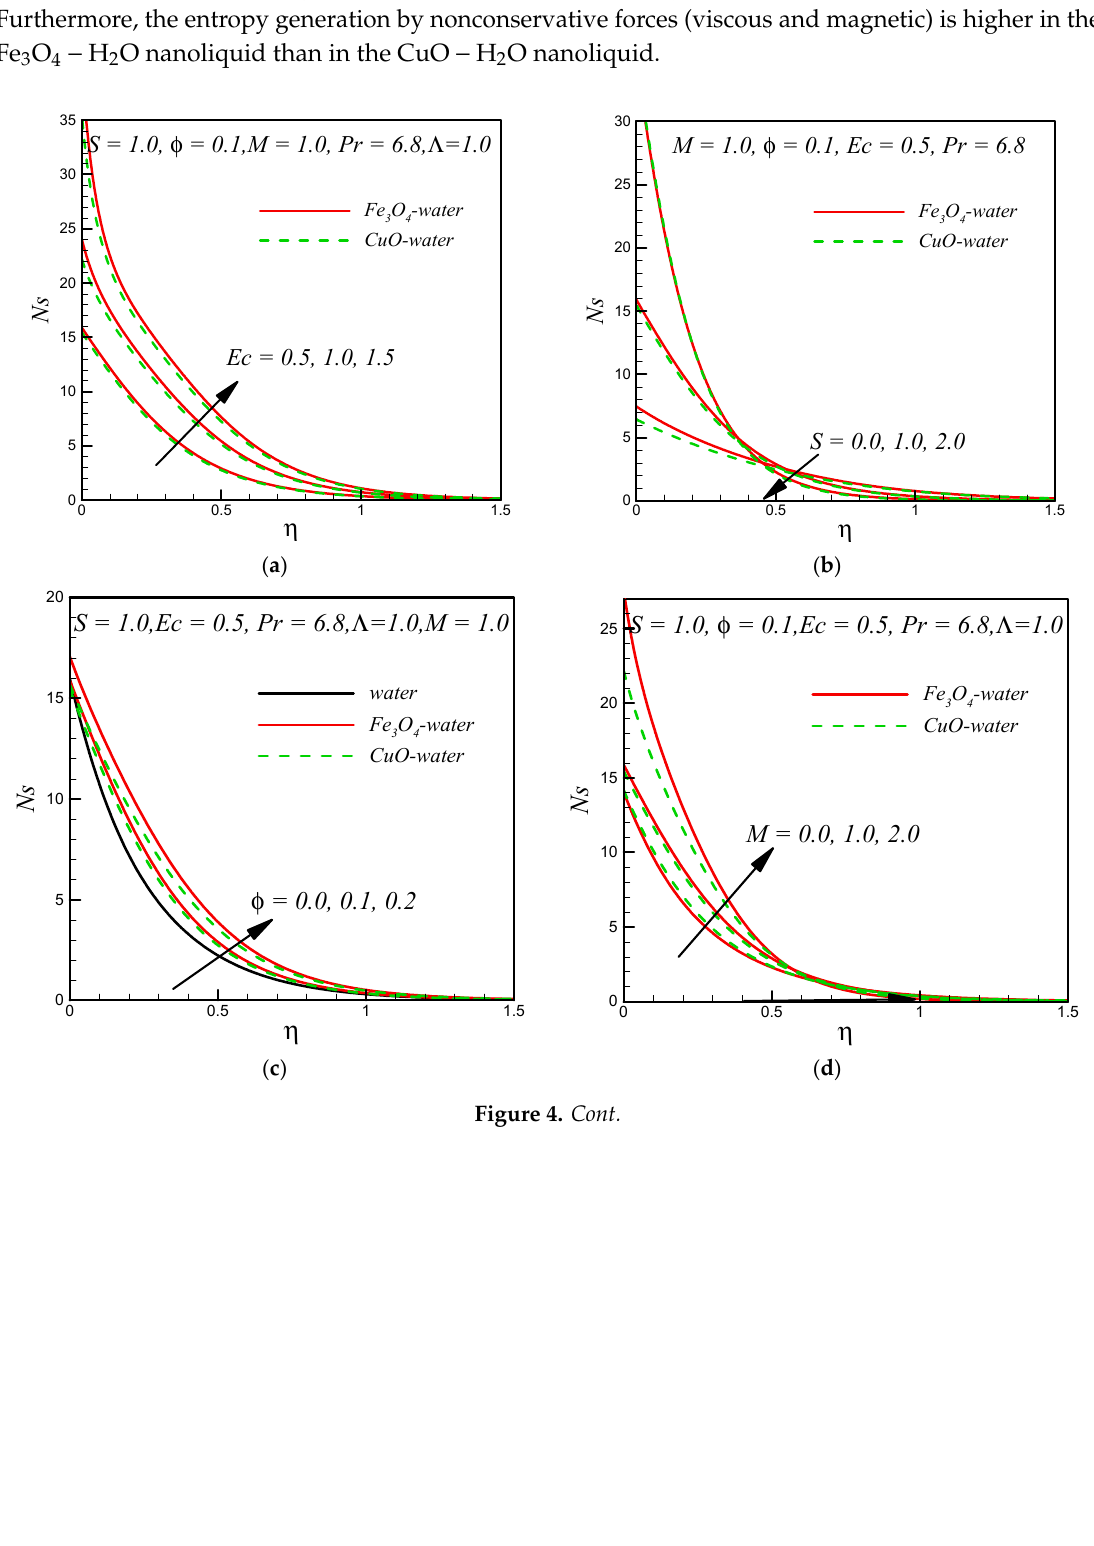
Figure 4. Variation of entropy generation profile 𝑁𝑠(𝜂) with ( a ) 𝐸𝑐 , ( b ) 𝑆, ( c ) 𝜙 , ( d ) 𝑀 , and ( e ) 𝛬 .